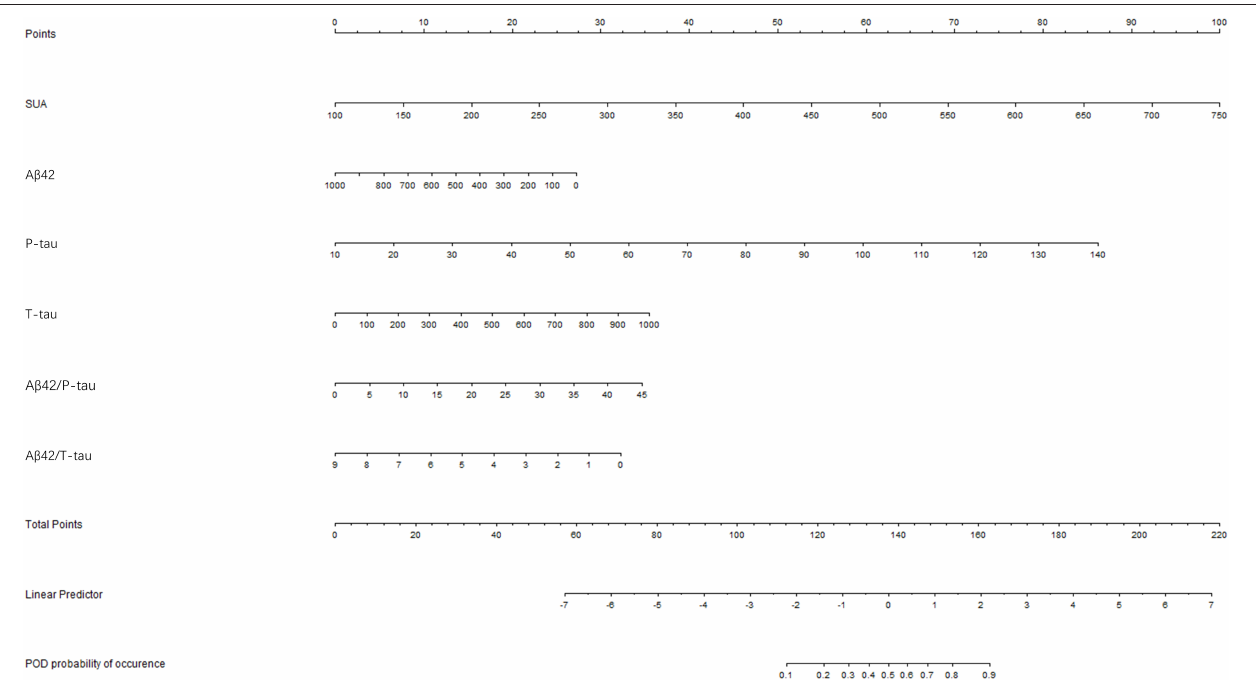
FIGURE 7 | Visualization for predictive factors. Nomogram showed the predictive ability of serum uric acid (SUA) and the Alzheimer-related